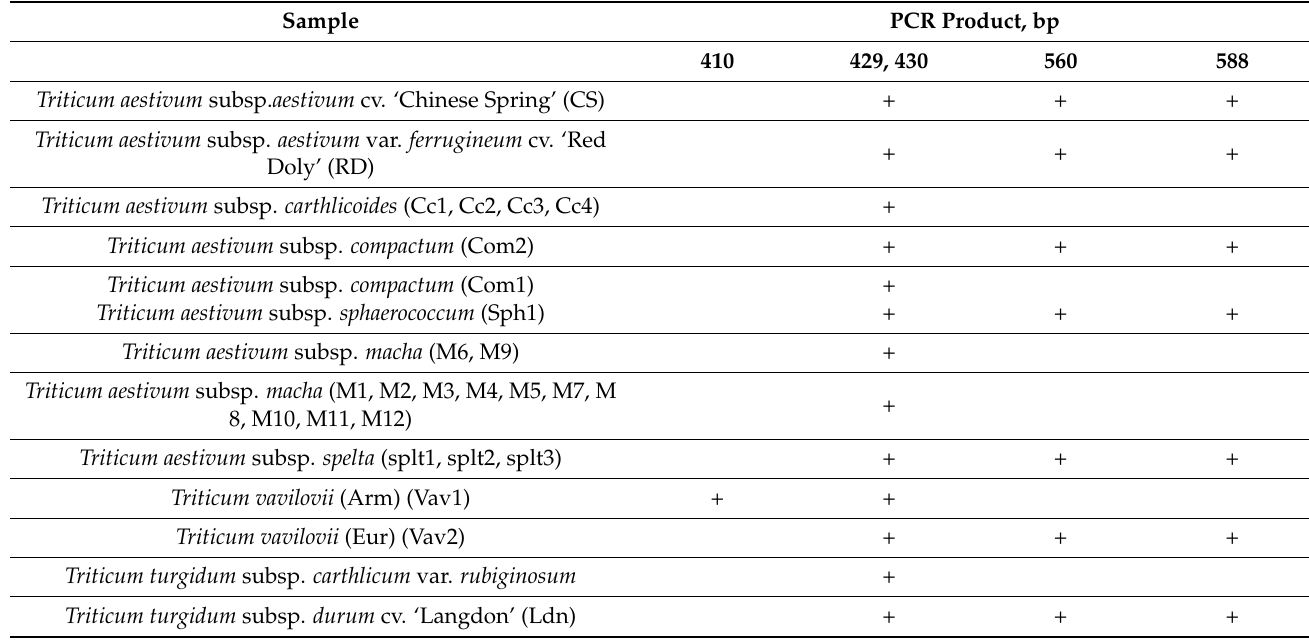
Table 8. PCR-based haplotype analysis of the fifth-to-sixth exon region of Wknox1b . Sample PCR Product,